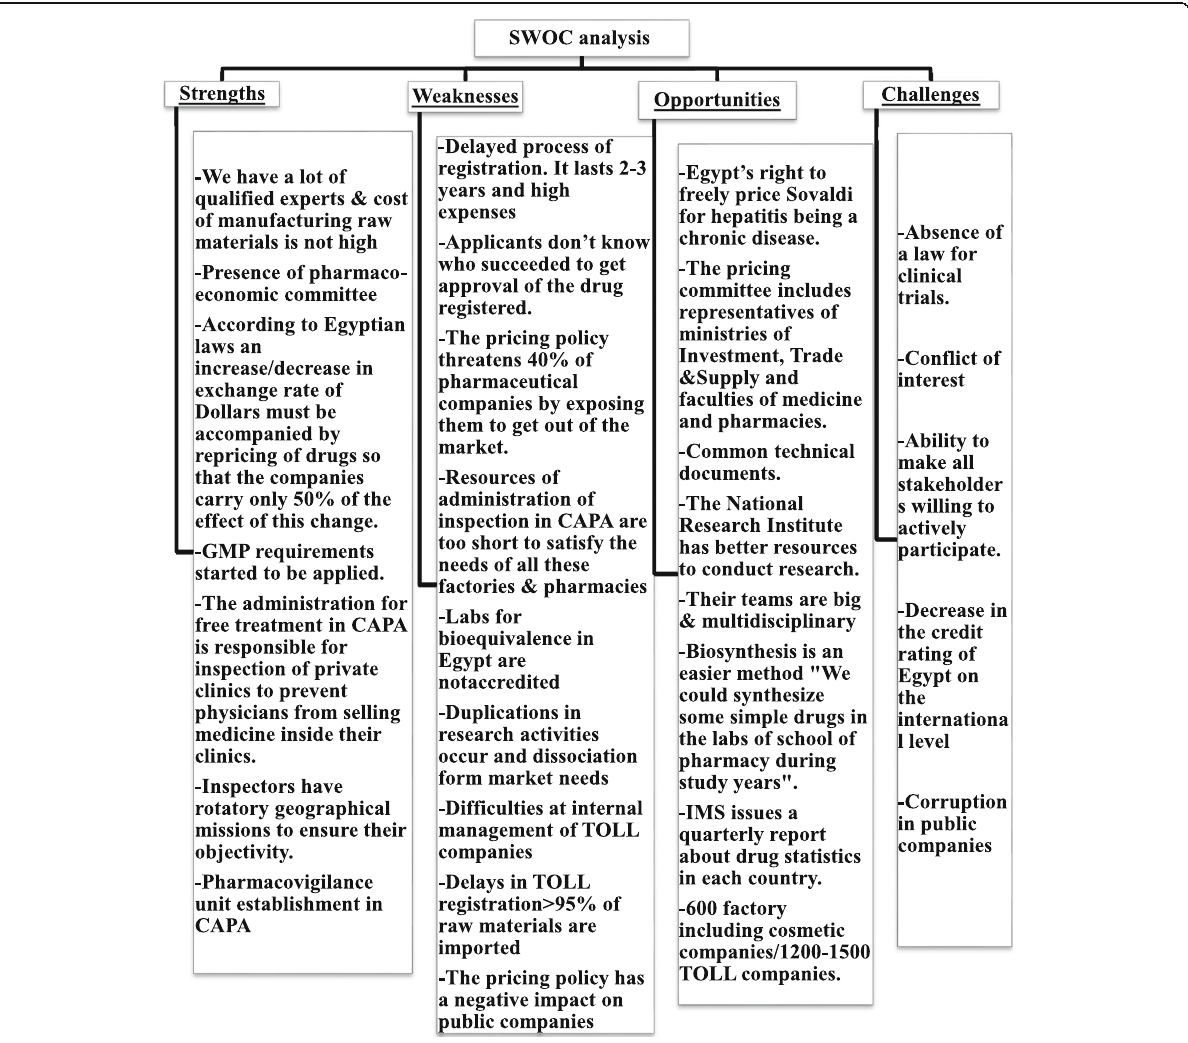
Fig. 2 Summarization of Strengths, Weaknesses, Opportunities and Challenges (SWOC) analysis done utilizing the available qualitative